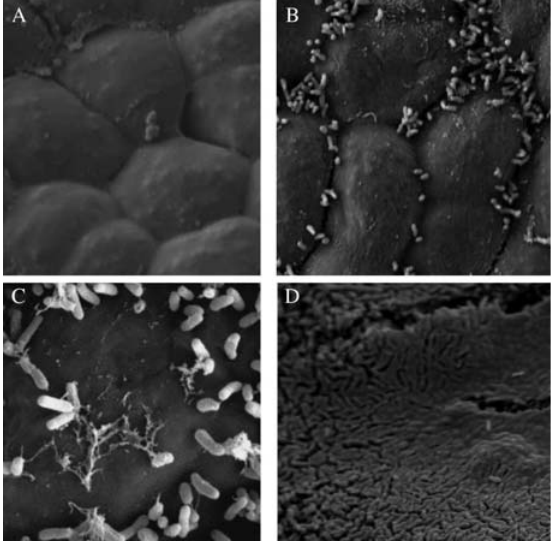
Figure 2 - A: scutelum cells of a sorghum immature embryo before inocu- lation with Agrobacterium . B: region of the scutelum close to the edge of the embryo, where Agrobacterium cells could be observed spread over the tissue.Inmostcells Agrobacterium cellsareconcentratedatthejunctionof cells. C: detail showing a cluster of Agrobacterium cells attached to each other and to sorghum cells by fibrils. D: immature embryo showing a dense layer of Agrobacterium cells organic substances that coated most of the embryo surface.